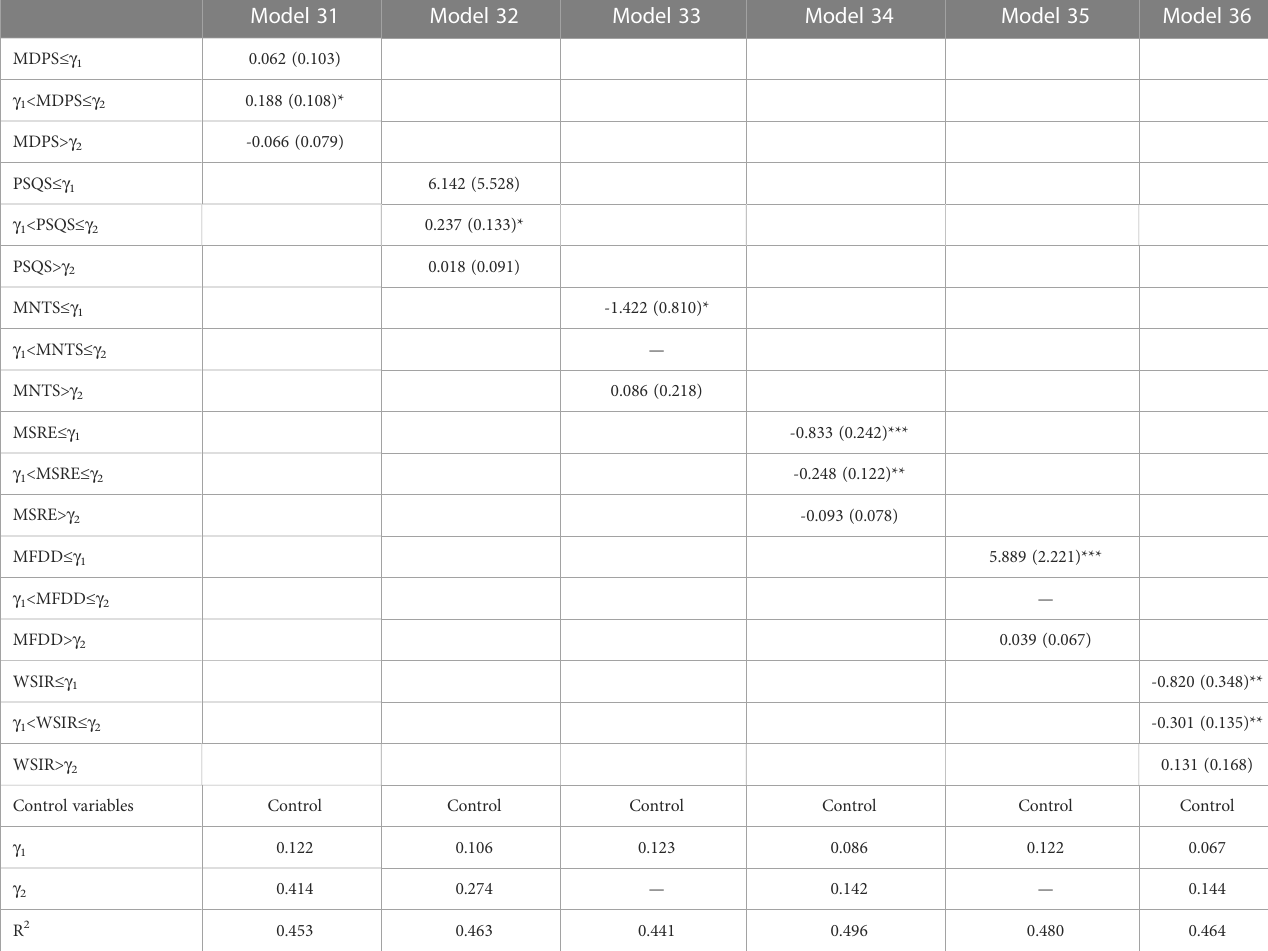
TABLE 6 The threshold model results of GECG in the non-major grain producing